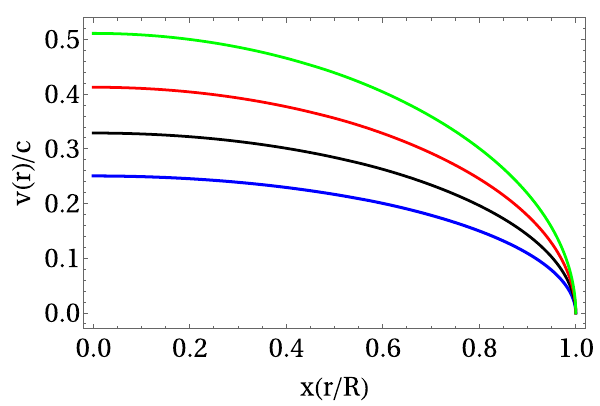
Fig. 6 v( r ) for Model I for compactness factor: 0.1 (blue line), 0.15 (black line), 0.20 (red line) and 0.25 (green